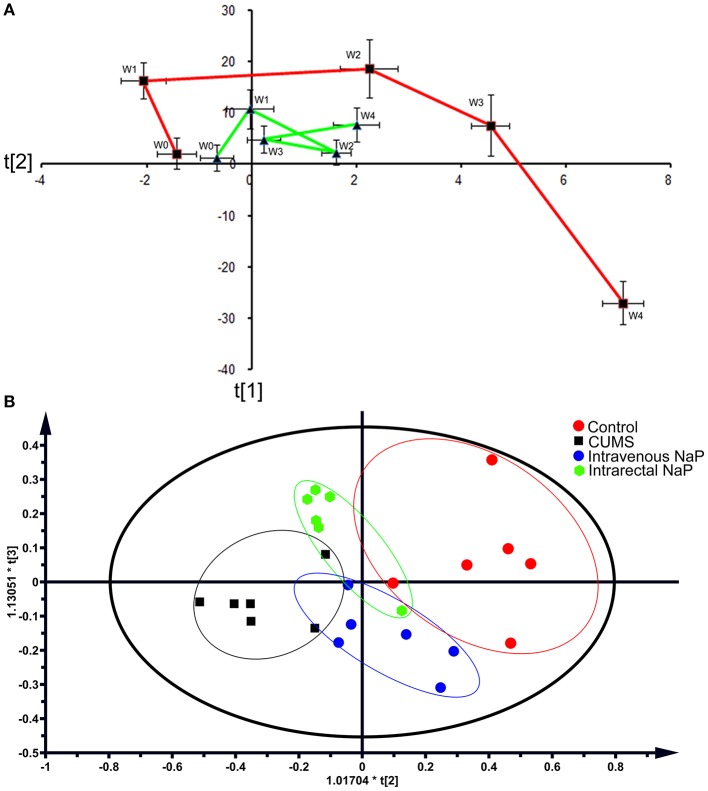
PCAs of the fecal metabolomes for the time-coursed trajectories (A) and the effects of NaP administration (B). For the time-coursed metabolomics trajectories analysis, dots represent the average metabolic status, and bar lines indicate the standard deviations of PC1 (horizontal axis) and PC2 (longitudinal axis) in the PCA model. The red and green lines represent the CUMS and the control groups, respectively. For the PCA plots of the effects of NaP administration, the red dots represent the control animals, the black dots represent the CUMS animals, the green dots represent the CUMS animals that received intrarectal administration of NaP, and the blue dots represent the CUMS animals that received intravenous administration of NaP with the same dose of the intrarectal administration group.